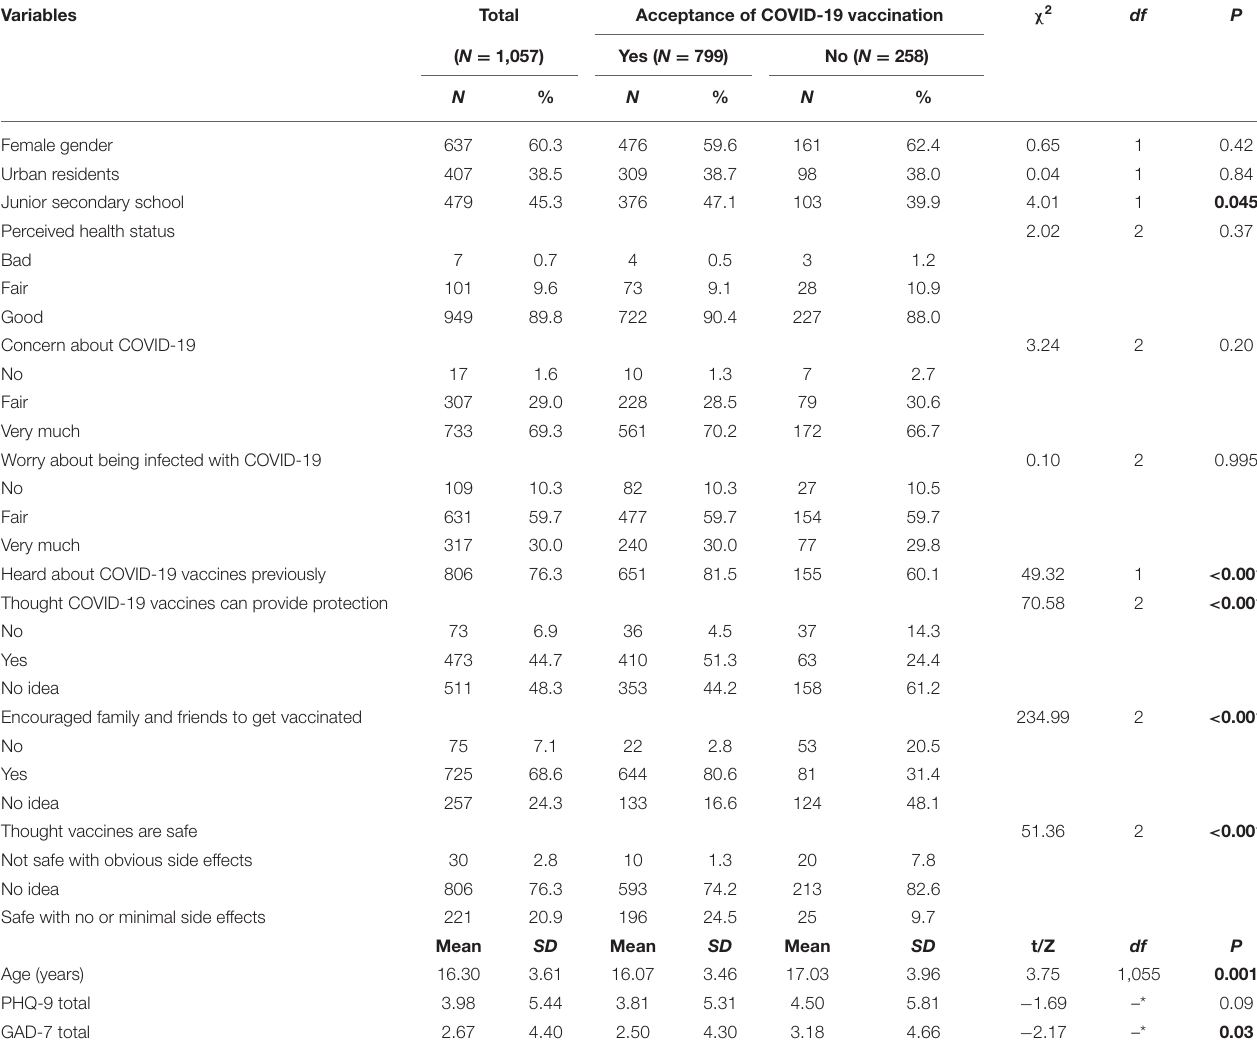
TABLE 1 | Demographic characteristics of